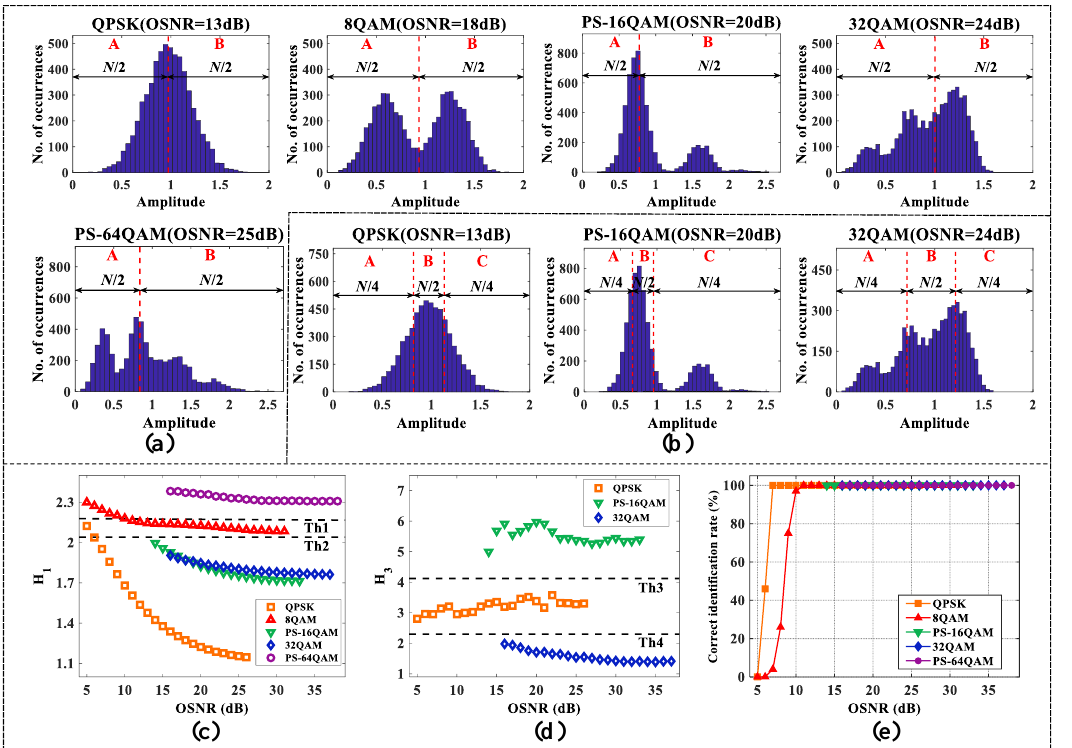
Figure 14. Operating principle and simulation results for identifying five modulation formats, including PS-QAM. ( a ) The first partition operation and ( b ) second partition operation for the amplitude histograms of QPSK, 8QAM, PS-16QAM, 32QAM and PS-64QAM; ( c ) H 1 and ( d ) H 3 vary with the OSNR of the back-to-back optical transmission system, and ( e ) the correct identification rate for identifying these five modulation formats.